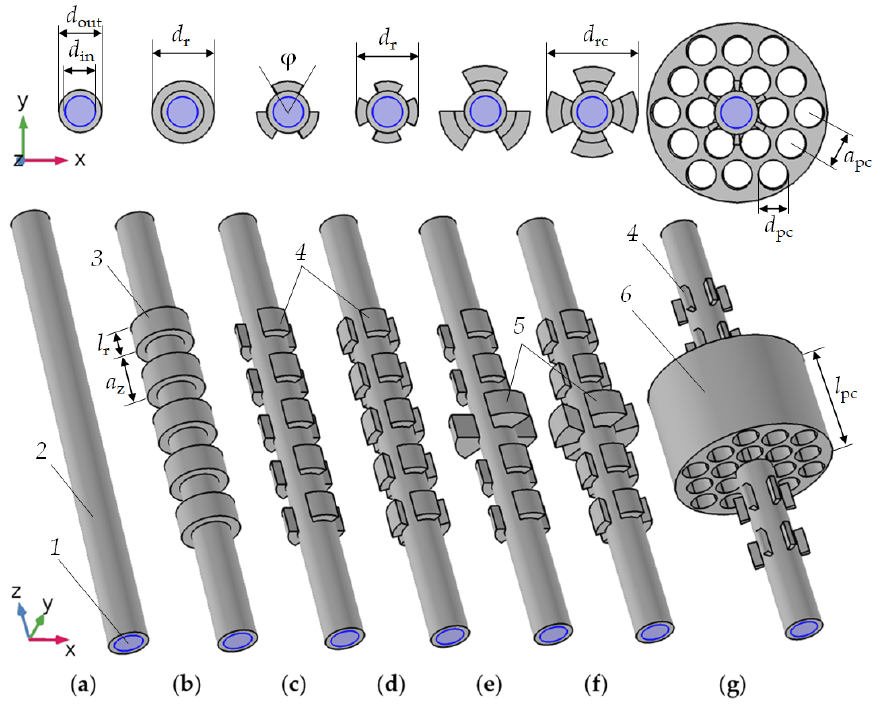
Figure 1. Model development of pipe-based resonators: a long liquid-filled pipe ( a ); a tubular phononic crystal with full ( b ) and sectioned rings periodically arranged along the pipe axis (3 ( c ) and 4 ( d )); tubular phononic sectioned rings, where the central ring sectors have a larger diameter ( e , f ); a tubular phononic crystal acting as a defect in a two-dimensional phononic crystal ( g ). Resonator models consist of the following elements: 1 —liquid; 2 —pipe; 3 —identical rings; 4 —equidistant sectioned rings; 5 —sectioned rings of a larger size in the centre of the pipe; 6 —2D phononic crystal made of a perforated cylindrical